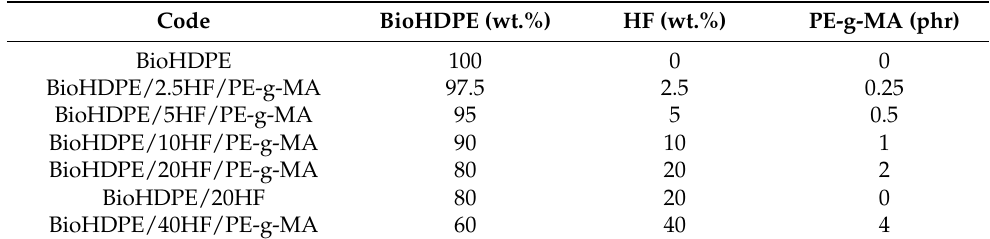
Table 1. Summary of compositions according to the weight content (wt.%) of Bio-HDPE and different proportions of Hemp fiber (HF) and PE-g-MA.